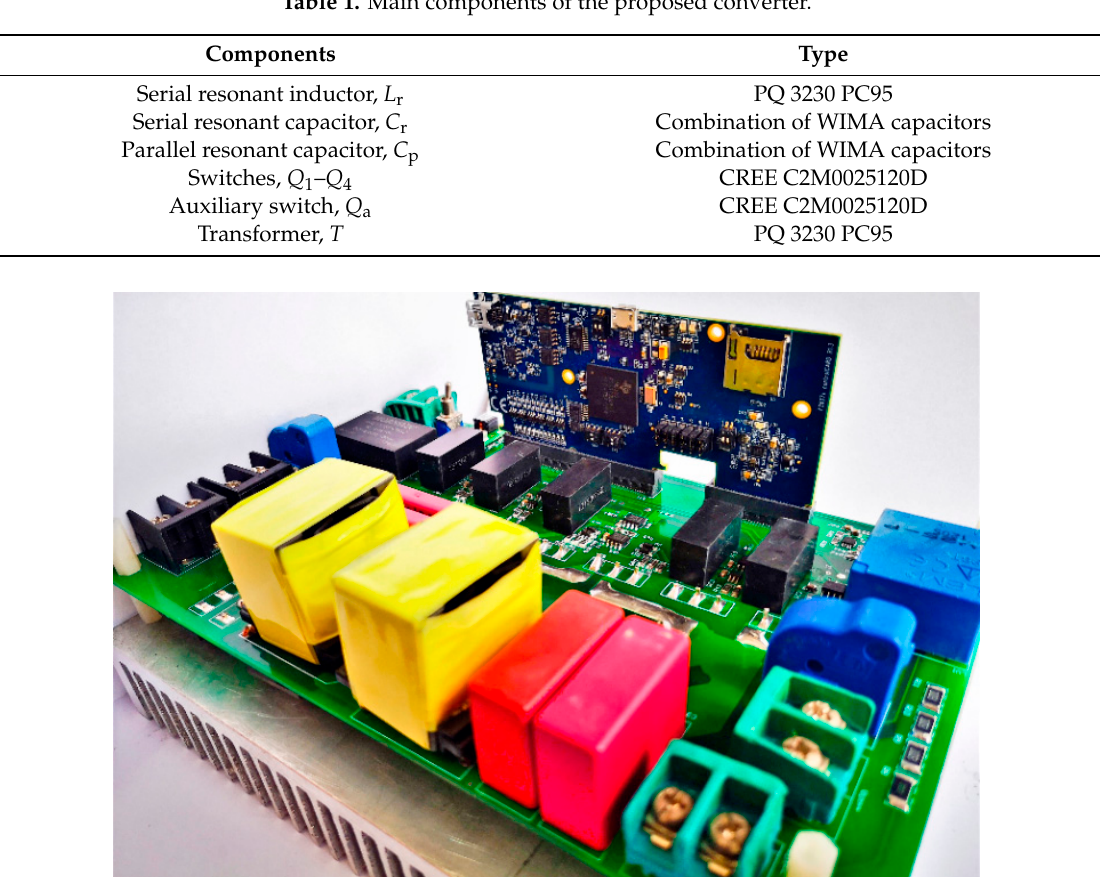
Table 1. Main components of the proposed converter.